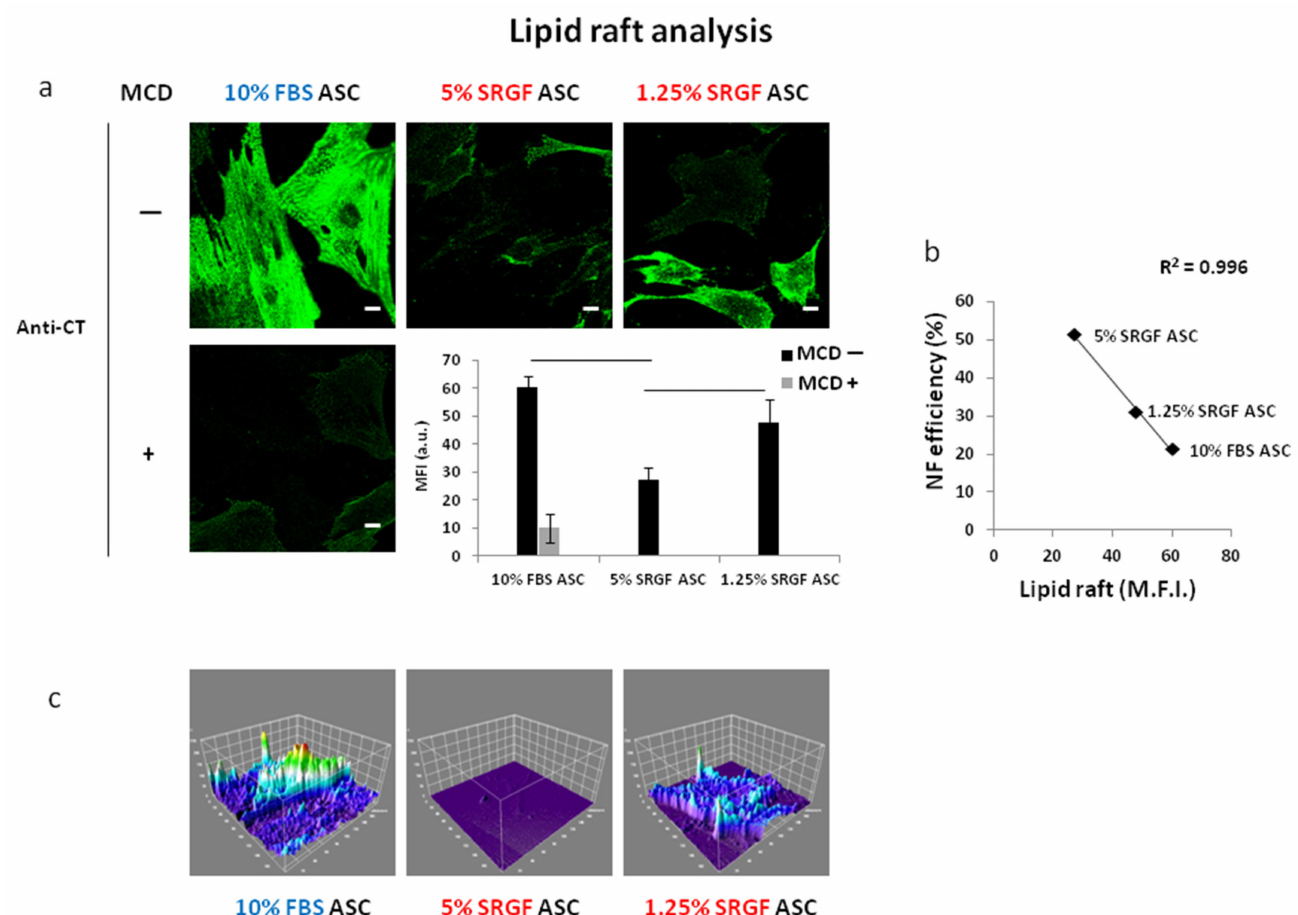
Figure 5. ( a ) shows representative images 10% FBS and 5% SRGF and 1.25% SRGF ASC labelled by fluorescent anti-CT antibodies (see Methods) to detect lipid raft availability on membranes. Methyl- β -cyclodextrin (MCD), a cholesterol scavenging compound, was used at sublethal concentration as technical control for assay specificity and it was applied only on 10% FBS ASC. Evaluation of mean fluorescence intensity as arbitrary units (M.F.I. (a.u.)) was also reported. ( b ) reports the correlation between lipid raft availability on cell membrane and NF efficiency evaluated in 10% FBS and 5% and 1.25% SRGF ASC. Solid lines connect significantly ( p < 0.01) different mean values. Scale bars 5 µ m. ( c ) reports a 3D surface plot analysis (ImageJ) graphically describing lipid raft signal intensity and distribution in single cells along the acquired z-stack. Reported images and (mean) quantification values represent results derived from at least three independent experimental